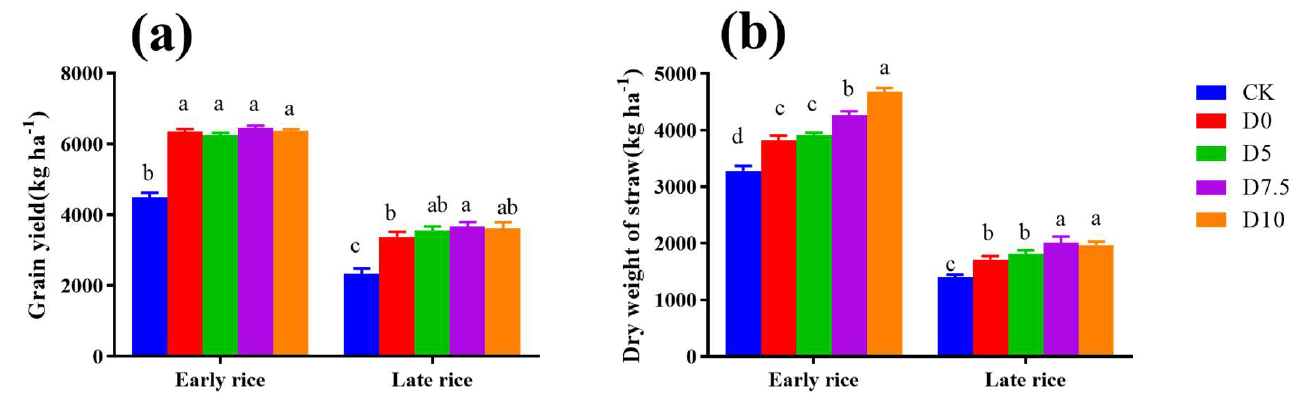
Figure 2. The grain yield and straw dry-matter weight of double-cropping rice. ( a ): The grain yield of early rice and late rice under different fertilization depths. ( b ): Straw dry-matter weight of early rice and late rice under different fertilization depths. Bars represent the standard deviations ( n = 3). CK: no fertilizer; D0: surface spreading; D5: 5 cm side-deep fertilization; D7.5: 7.5 cm side-deep fertilization; D10: 10 cm side-deep fertilization. Different lowercase letters in the figure indicate significant difference among treatments at p = 0.05